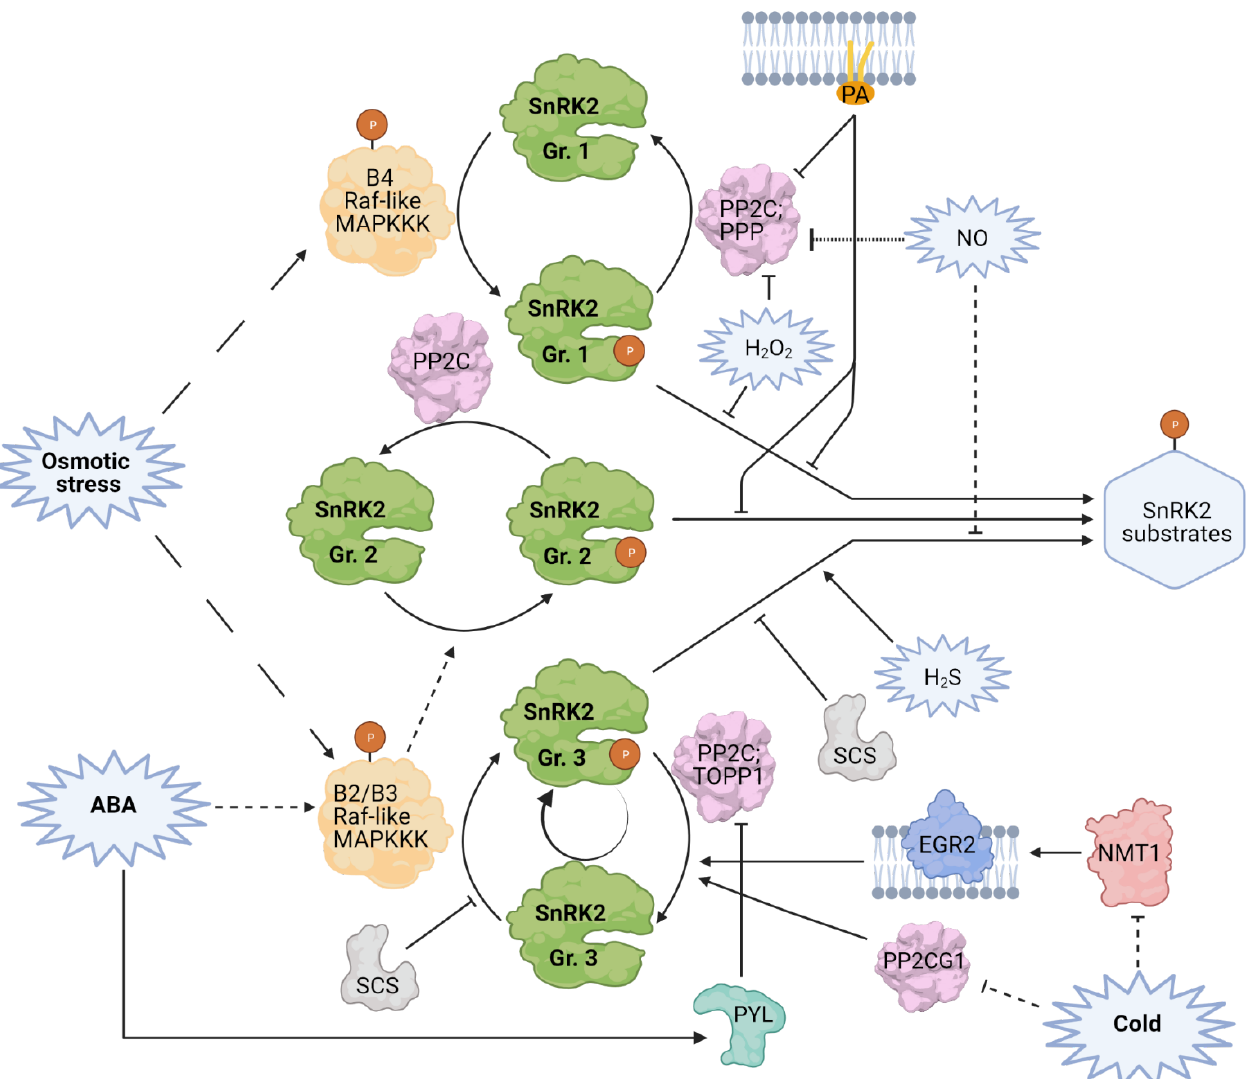
Figure 2. Diverse modes of regulation of SnRK2 activity. Solid lines indicate experimentally shown direct interactions, dashed lines indicate indirect interaction or multistep process. Dotted lines represent hypothetical regulation. Lines with arrowheads indicate positive regulation, bar-ended lines indicate inhibition. SnRK2s activation relies on phosphorylation of specific residues in their activation loops. All SnRK2s are activated by osmotic stress, in the case of SnRK2s from group 1 and 3 via phosphorylation by Raf-like MAPKKK from subfamilies B4 or B2 and B3, respectively. SnRK2 kinases from group 3 and (most likely) 2 are activated by ABA via phosphorylation by Raf-like MAPKKK from subfamilies B2 and B3. ABA-dependent activation can be amplified by autophosphorylation. In the absence of ABA, SnRK2s from group 3 interact with type 2C protein phosphatases (PP2Cs) and Type One Protein Phosphatase 1 (TOPP), which dephosphorylate their activation loops, rendering them inactive. When present, ABA binds to PYL (PYR1-LIKE) ABA receptors, which causes their interaction with and inactivation of the phosphatases, allowing for SnRK2 release and activation. Other PP2Cs — clade E Growth-Regulating 2 (EGR2) and PROTEIN PHOSPHATASE 2C G GROUP 1 (PP2CG1) — negatively regulate group 3 SnRK2 kinases. Cold attenuates SnRK2 inhibition by the latter two, in the case of EGR2 by reducing its N -myristoy- lation. SnRK2-interacting calcium sensor (SCS) negatively impacts the function of group 3 SnRK2s by blocking kinase activation and activity towards substrates. SnRK2s from all groups are negatively regulated by PP2Cs and serine/threo- nine-specific phosphoprotein phosphatases (PPPs). Secondary messengers — PA (phosphatidic acid), H 2 S, NO, H 2 O 2 — im- pact the activity of specific SnRK2s. H 2 S enhances SnRK2.6 activity by persulfidation of its Cys residues. NO inhibits group 3 SnRK2s through S-nitrosylation; on the other hand, it contributes to activation of group 1 SnRK2, probably in an indirect fashion. H 2 O 2 inhibits the activity of BnSnRK2.4-1C from group 1 via oxidation of Cys233. PA, H 2 O 2 , and probably NO